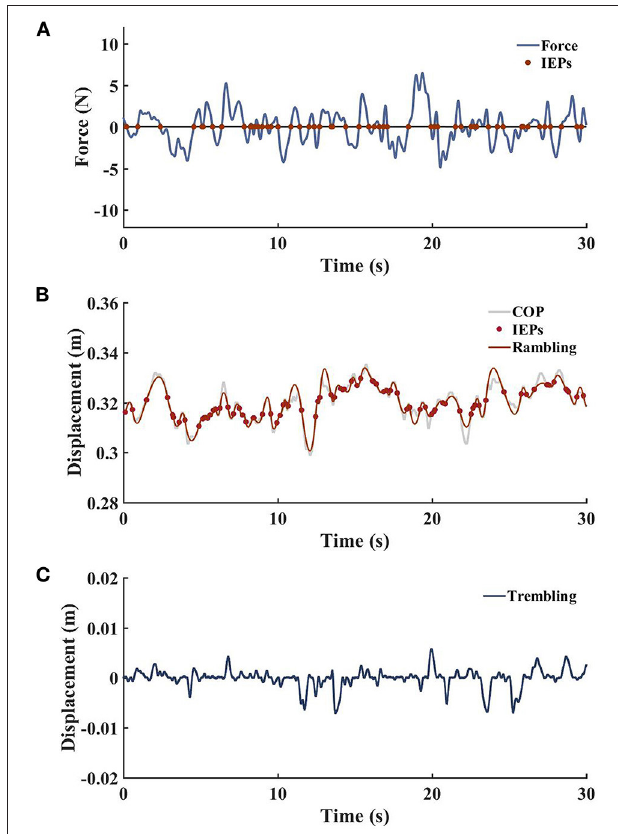
FIGURE 3 | Sequence of operations used for center of pressure (COP) trajectory decomposition. (A) Instant equilibrium points (IEPs) occur when the horizontal force component is zero (or very close to zero). (B) In the COP displacement data, the COP positions at the instants (IEPs) are located, and the spline interpolated rambling trajectory is shown. (C) Trembling trajectory, the difference between COP and interpolated rambling trajectories.